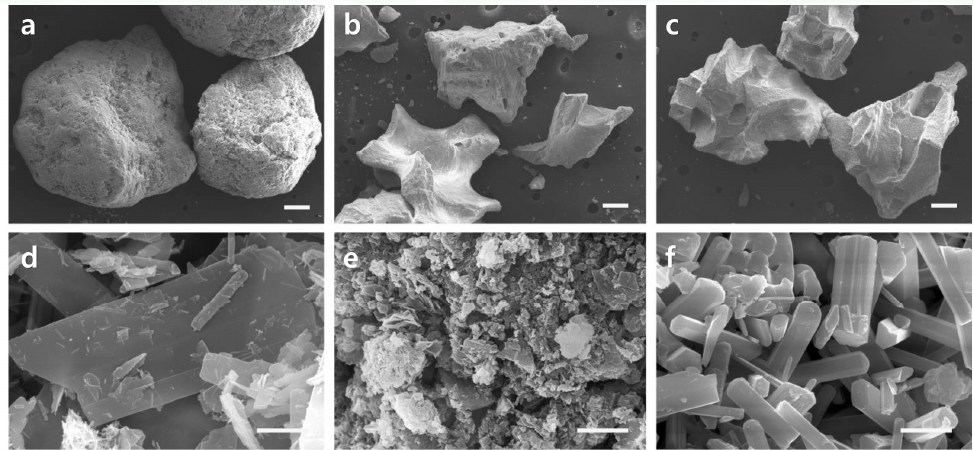
Figure 1. Scanning electron micrographs of OCP ( a , d ), BHA ( b , e ), and BCP ( c , f ) granules. The bars indicate 200 μ m at lower magnification ( a – c ) and 1 μ m at higher magnification ( d – f ).